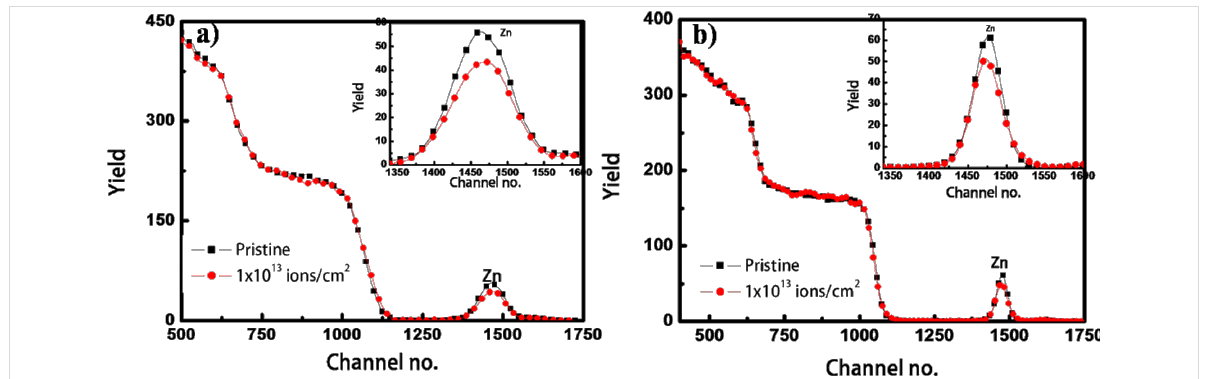
Figure 2: RBS spectra of Zn–silica nanocomposite thin film before and after irradiation, (a) 2 atomic % Zn in silica, (b) 10 atomic % Zn in silica. The inset in both figures shows the zoomed Zn peak for clarity.